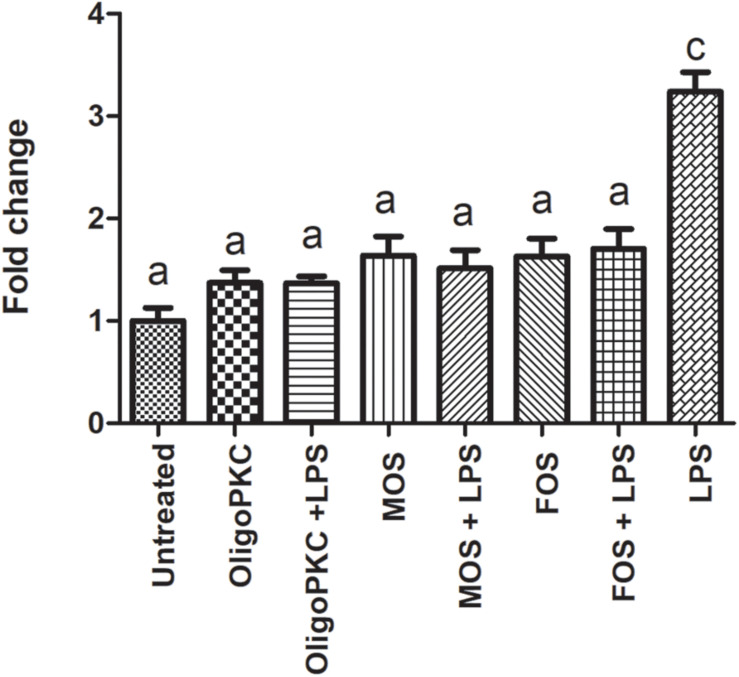
Fluorescence intensity of zebrafish larvae at 7 dpf treated with OligoPKC, MOS, FOS, a combination of different oligosaccharides and LPS. The values represent the mean ± SEM of three biological replicates with each biological replicate containing (n = 6) fishes. Statistical analysis was done using Kruskal-Wallis test followed by Dunn’s Multiple Comparison Test. Means with the same letter are not statistically significant (p > 0.05) from each other.